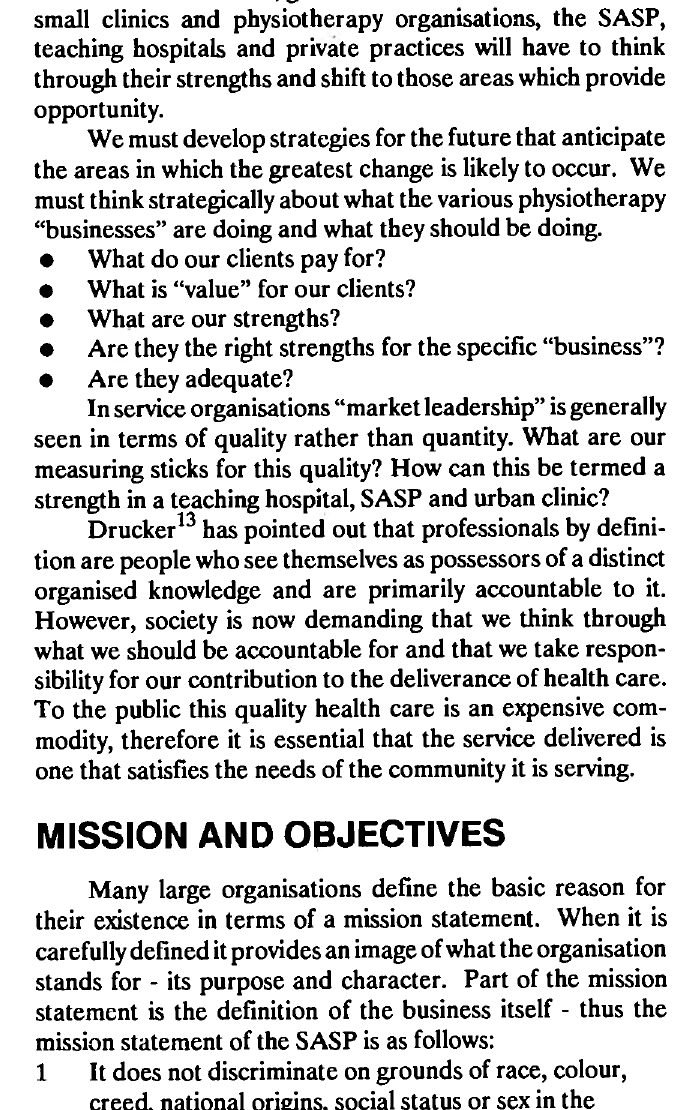
Figure 8: SWOT ANALYSIS : SASP EXECUTIVE